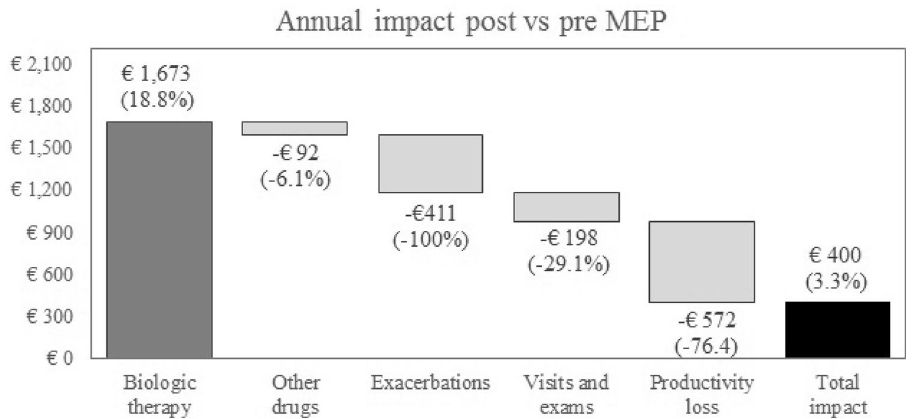
Figure 2. Mean annual economic impact of switching from OMA to MEP. MEP mepolizumab, OMA